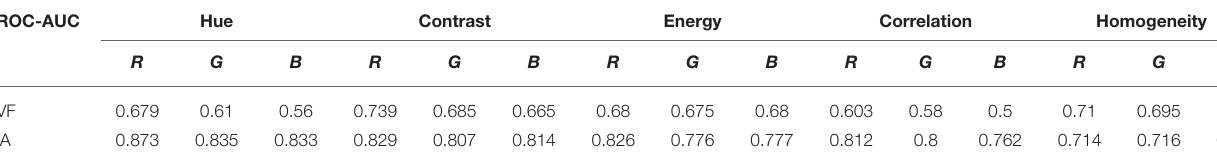
TABLE 1 | ROC-AUC curve analysis of different hue and texture features for vocal fold (VF) and interarytenoid region (IA). ROC-AUC Hue Contrast Energy Correlation Homogeneity